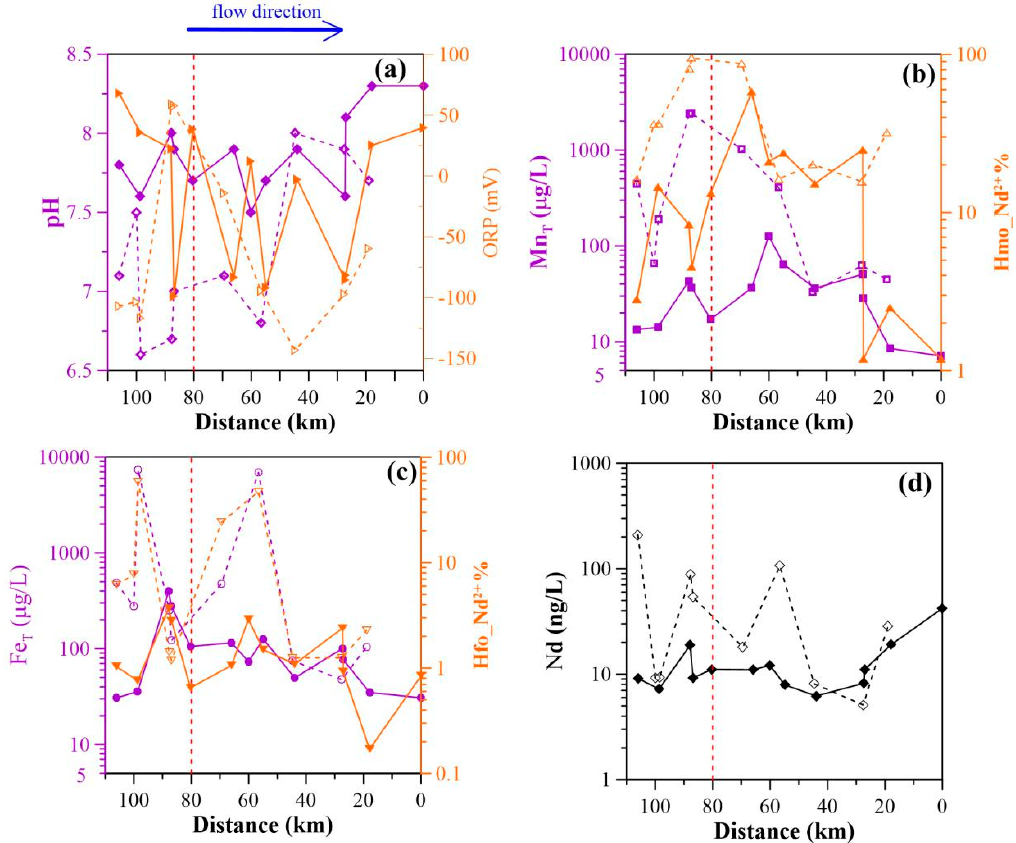
Figure 2. ( a ) Physicochemical parameters (pH, ORP) and ( b ) manganese concentration and proportion of Nd sorbed by hydrous manganese oxides (HMO), ( c ) iron concentration and proportion of Nd sorbed by hydrous ferric oxides (HFO) and ( d ) concentrations of Nd as a function of distance from the sampling location of sample D-13 (Bohai seaside) (The dash line denotes shallow groundwater, while the solid line indicates deep groundwater; pH, ORP, Fe, Mn, Nd parameters were determined by experiment; the amounts of Nd sorbed by HMO and HFO were determined by modeling). The oxidation–reduction potential (ORP) ranged from − 143 mV to 59 mV (mean − 62 mV) in shallow groundwater, and from − 99 mV to 68 mV (mean − 16 mV) in deep groundwater, respectively,